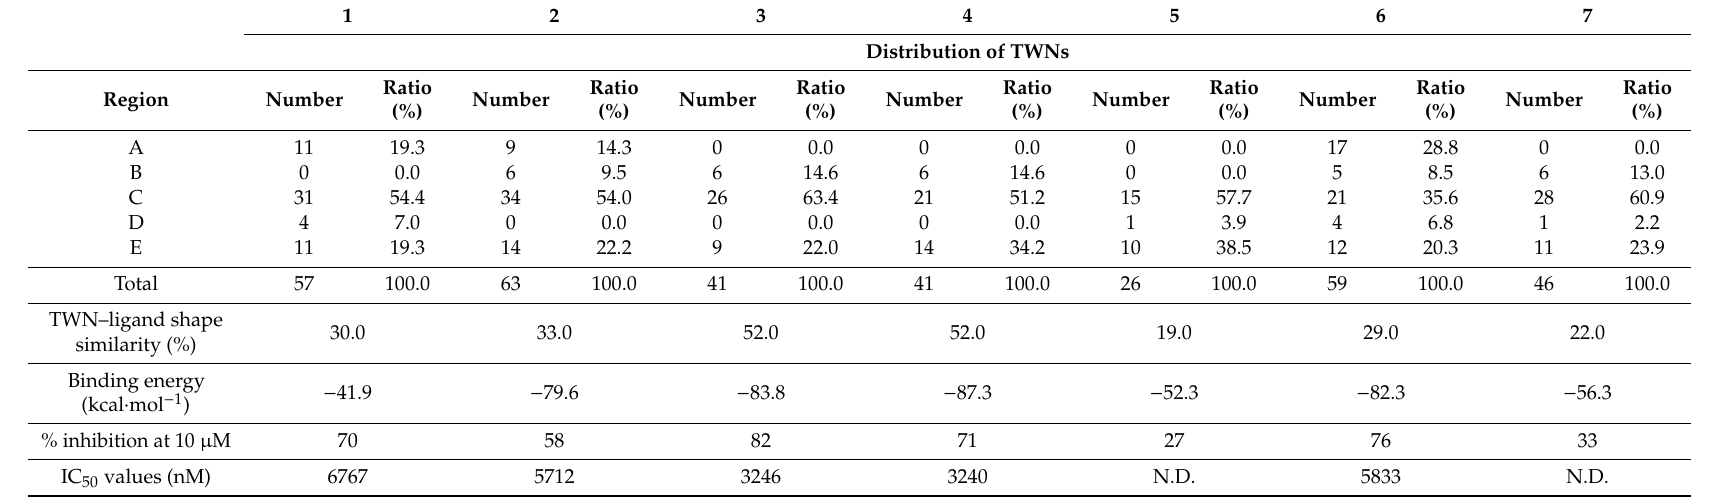
Table 2. Summary of TWNs, Binding Energy and In Vitro Results for the Screened Compounds 1–7 against